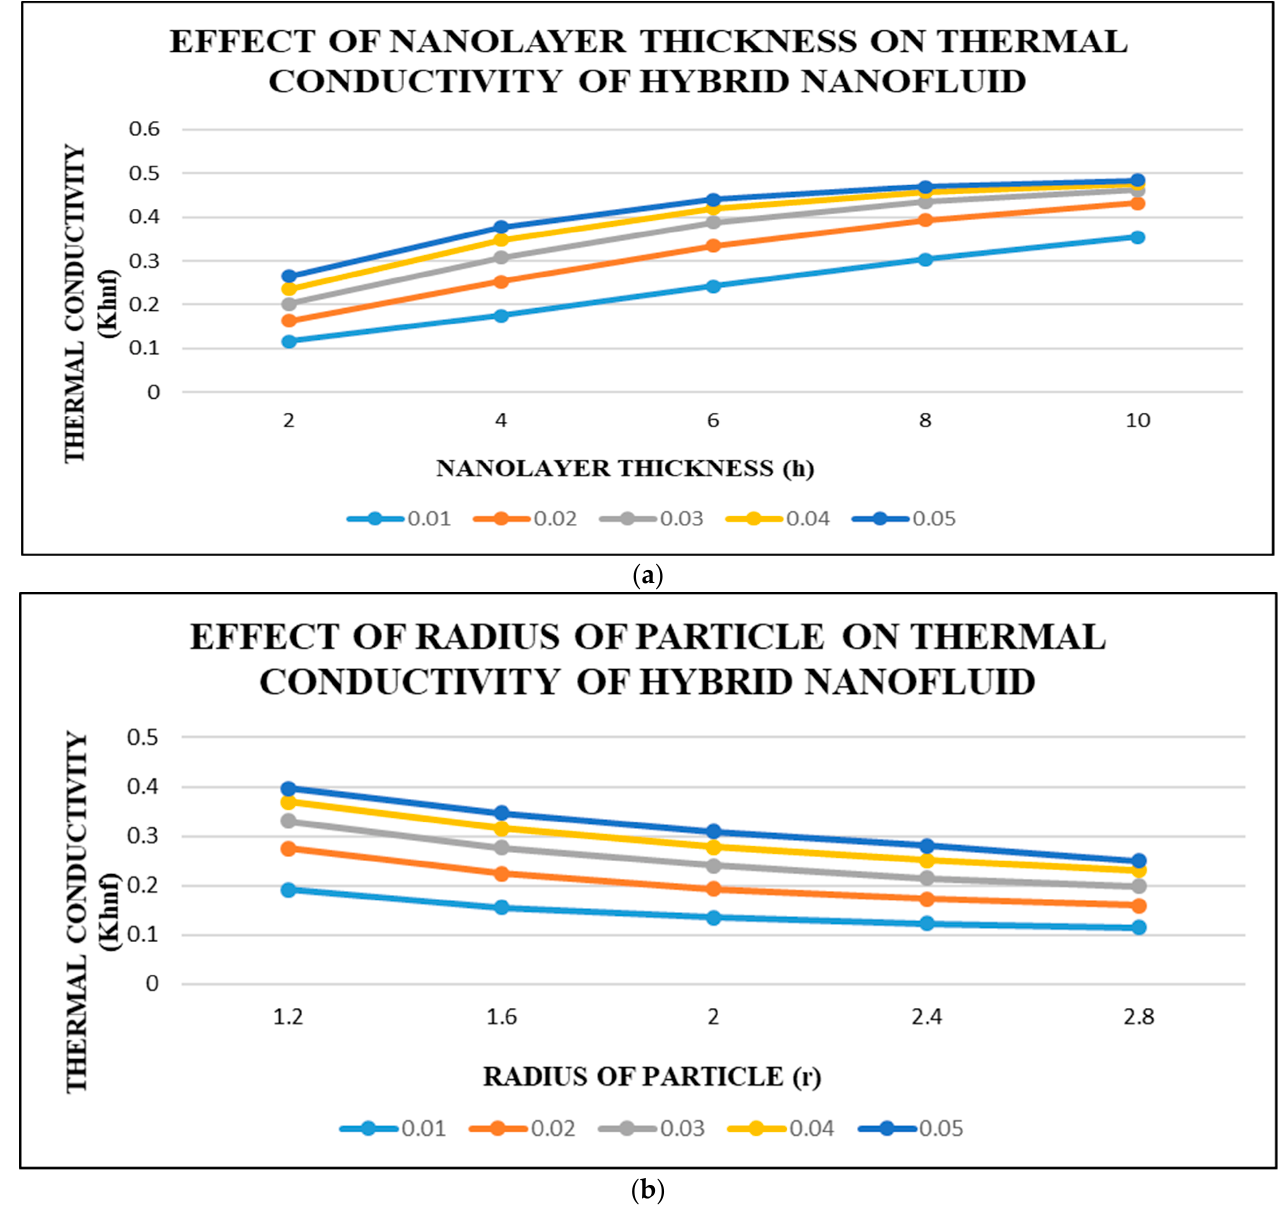
Figure 3. Results of T.C. on thickness ( a ) and radius ( b ).